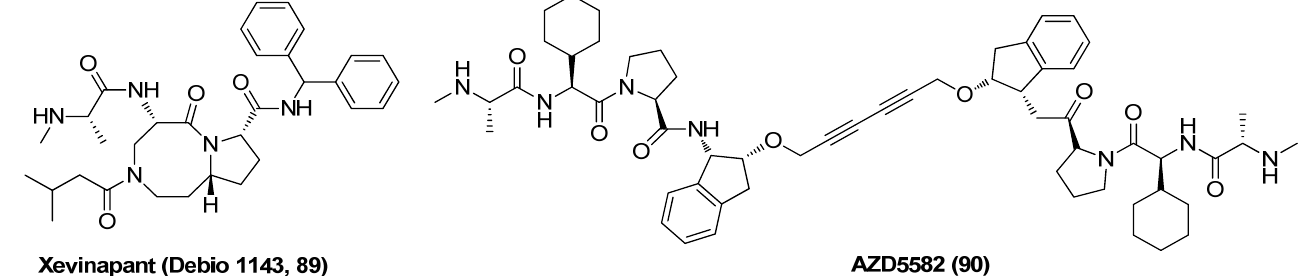
Figure 19. Chemical structure of two IAP antagonists 89 and 90 as LRAs.